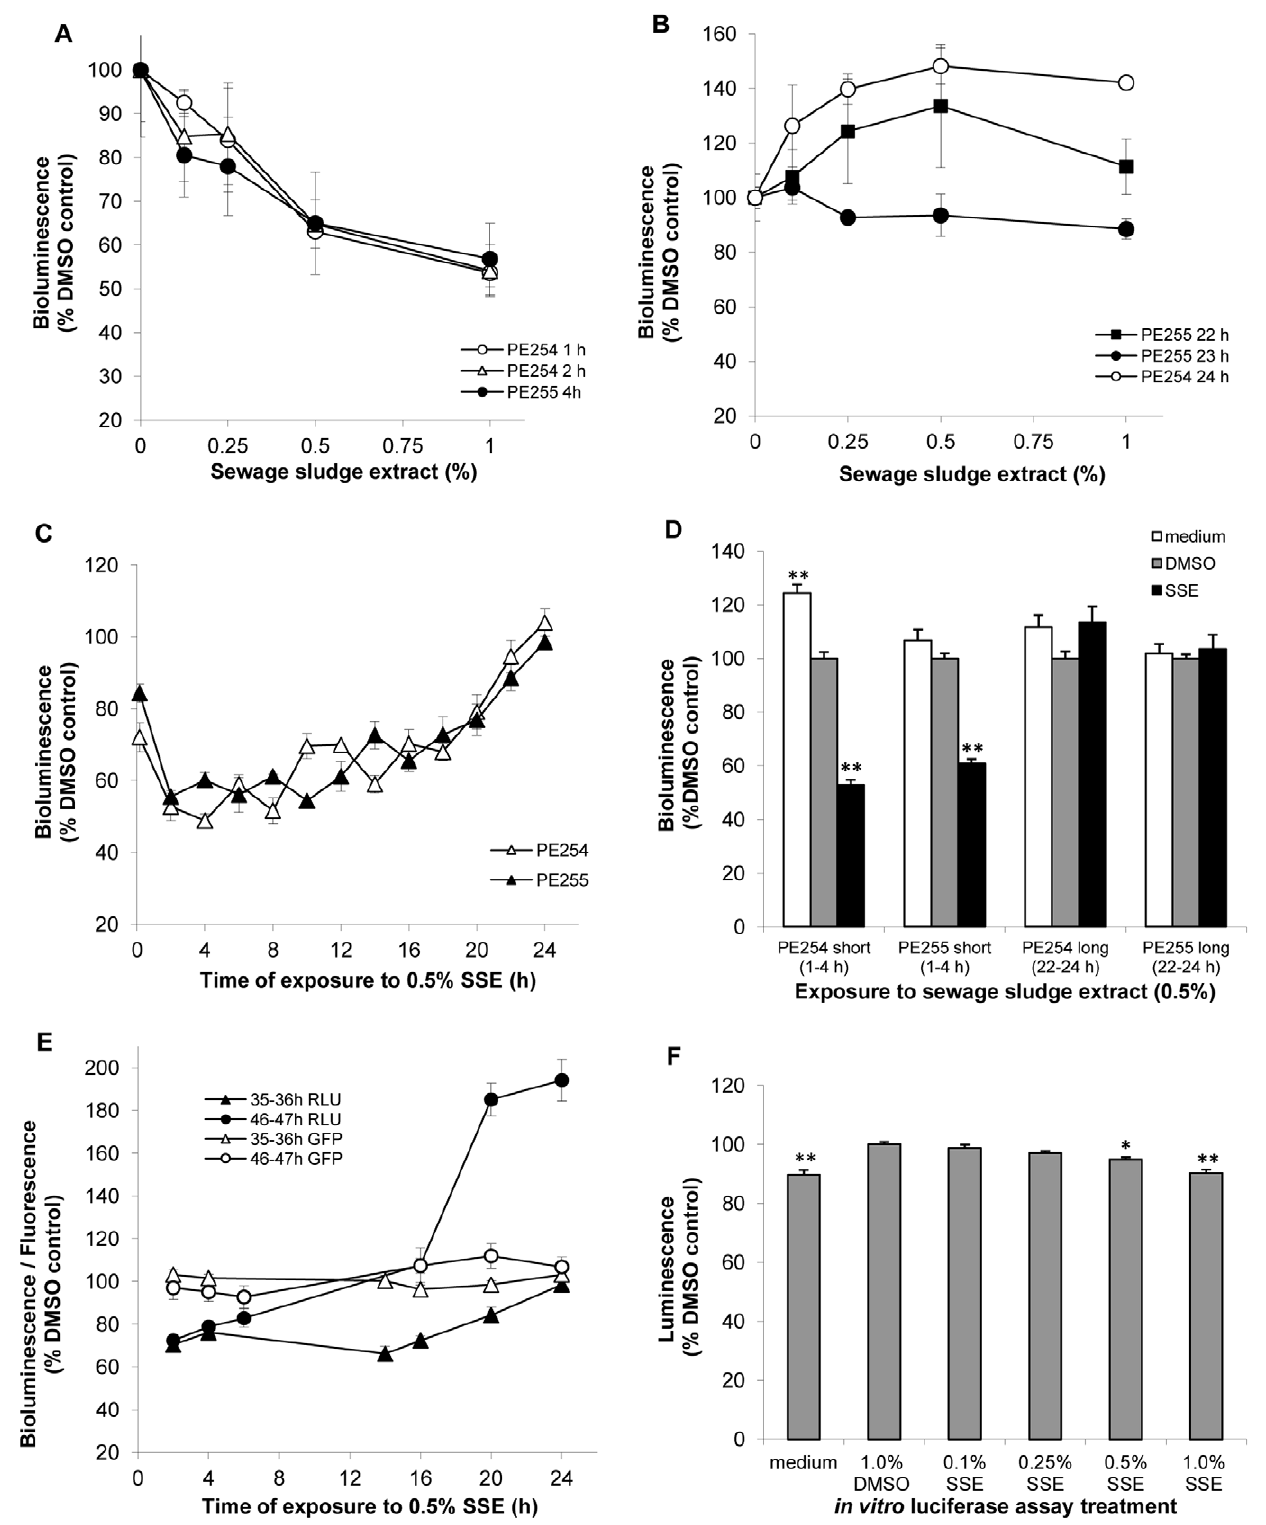
Figure 1. Metabolic health of C. elegans is compromised after short but not long exposure to SSE. Synchronised, L4 stage worms (46– 47 h) growing in S-complete medium with OP50 as food source were exposed to SSE or DMSO in 96 well plates. Bioluminescence was expressed as a percentage of the DMSO (1%) solvent control values. (A) Short exposure to SSE (0, 0.1, 0.25, 0.5 and 1.0%): 3 independent experiments carried out at different times shown. Error bars for each experiment depict SEM of technical replicates at each SSE concentration (n=3). SSE had a significant effect on bioluminescence p , 0.001 (no difference between experiments p . 0.05). (B) Long exposure to SSE (0, 0.1, 0.25, 0.5 and 1.0%): 3 independent experiments carried out at different times shown. Significant effect of SSE concentration on bioluminescence: closed squares (p=0.004), open circles